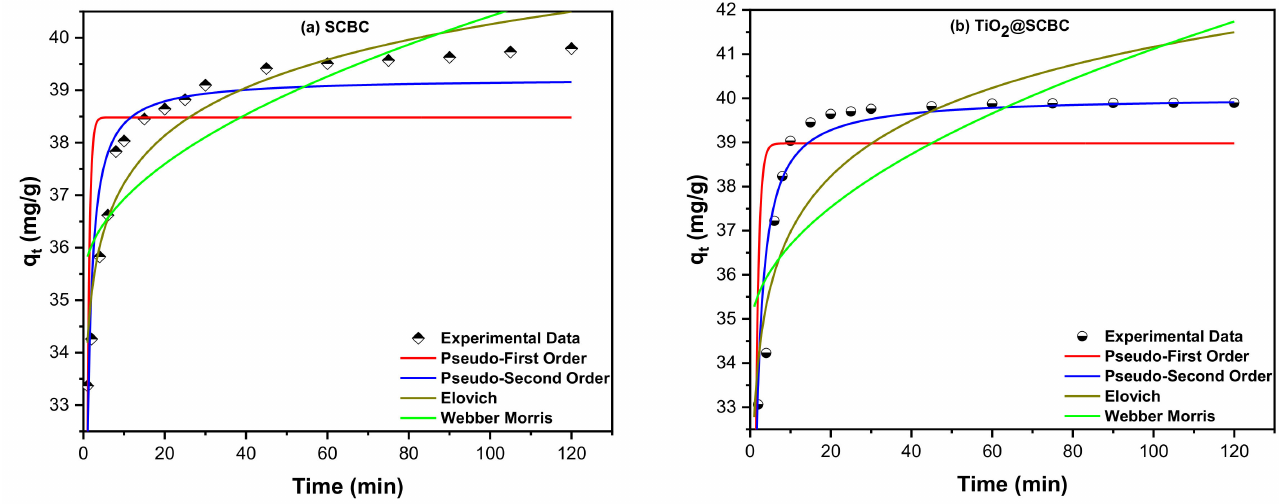
Figure 10. Kinetics of the adsorption of BALX onto ( a ) SCBC and ( b ) TiO 2 @SCBC including PSO, PSO, Elovich, and Weber–Morris